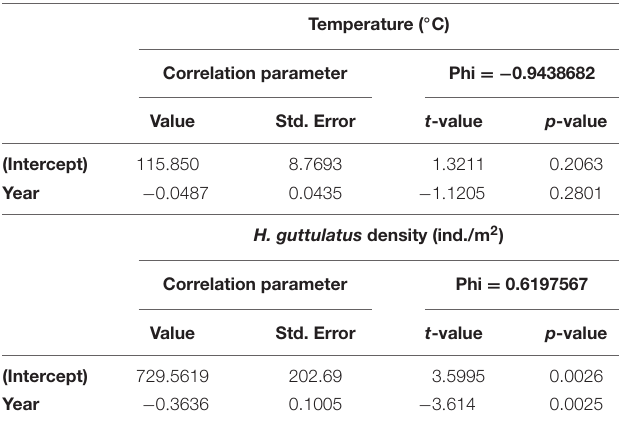
TABLE 2 | Breakpoint regression analysis results indicating significant differences in the seahorse density before and after an estimated break in 2016.